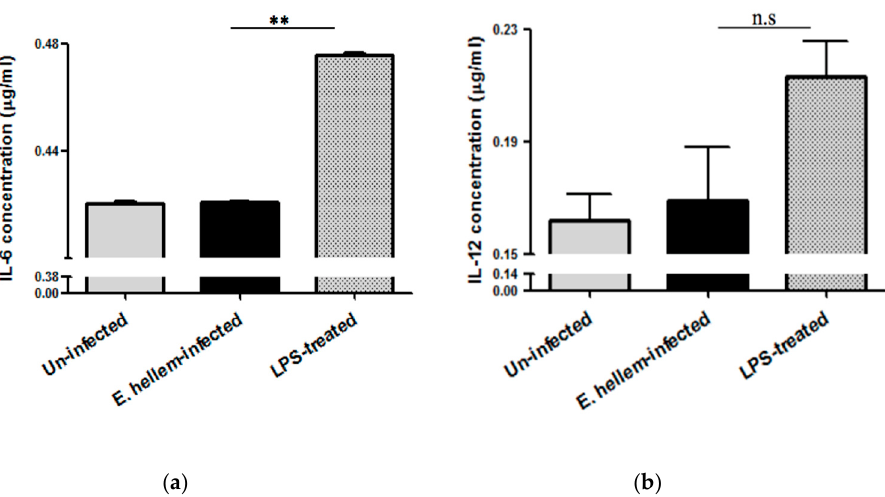
Figure 4. Cytokines expressions. Plasma samples were prepared from the peripheral blood of uninfected, E. hellem -infected and LPS-treated mice respectively. ( a ) Cytokine IL-6 expression levels were measured by mouse IL-6 ELISA Kit. Results showed that LPS would significantly upregulate IL-6 expression level, while E. hellem infection did not upregulate IL-6 expression (** = p < 0.01, n = 8 for each group). ( b ) Il-12 expression levels were quantified by mouse IL-12 ELISA Kit. Results also confirmed that E. hellem infection did not upregulate IL-12 expression, although no statistical